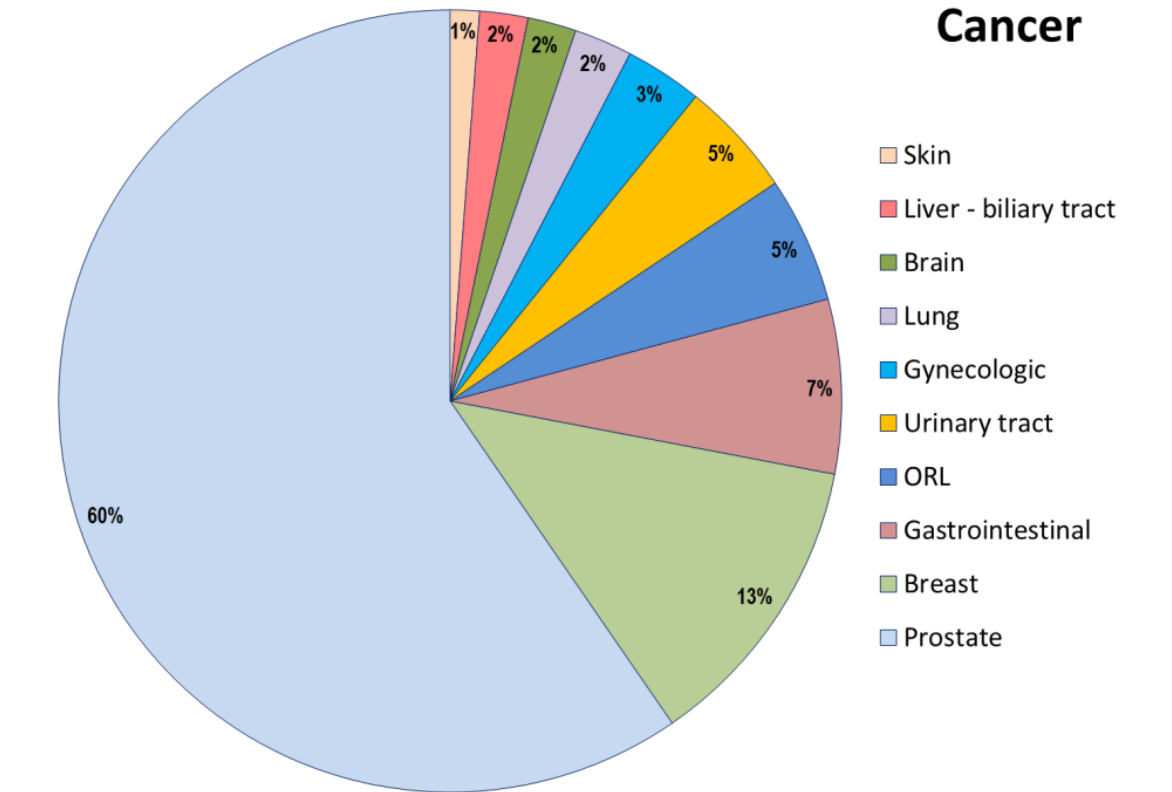
Figure 3. Cancer type in the outpatient population .